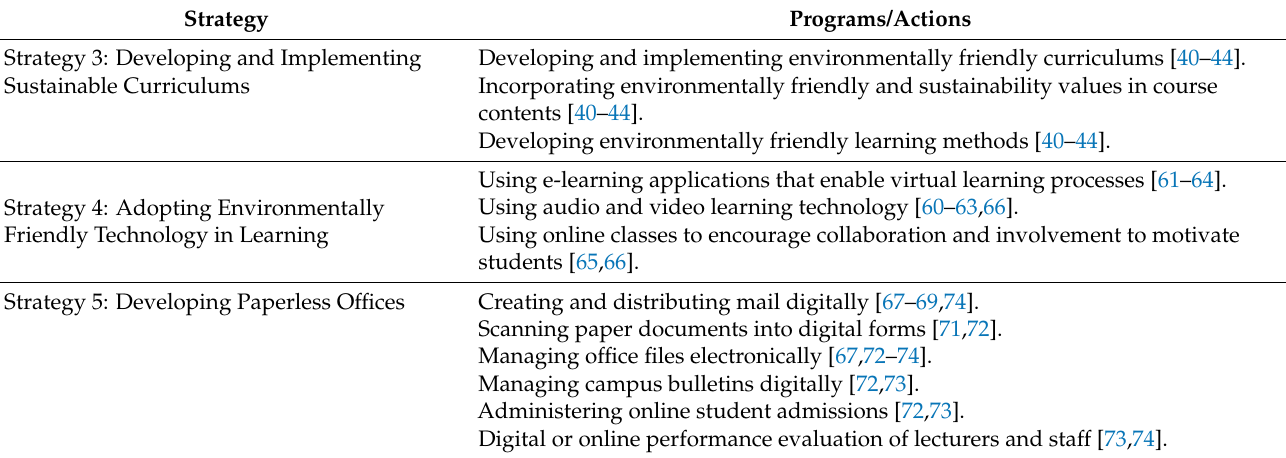
Table 2. Strategies in the learning tool